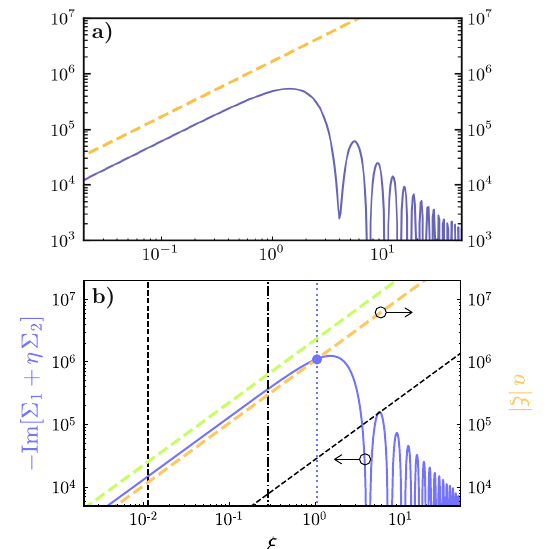
Figure 6. Steady-state solution for the mechanical displacement amplitude that ( a ) doesn’t reach a limit cycle, and ( b ) gets into a limit cycle. ( a ) The crossing of the left and right side of Equation (47) are reported as dashed–orange (for the first most coupled mode) and solid–blue curve, respectively. The oblique orange line represents the left term in Equation (47). The equation is not satisfied because the pump power is below the threshold for finding a root. ( b ) The intersection of left and right side of Equation (47) for the parameters of reference [23], are reported dashed–orange and solid–blue = 1.054, and an effective curves, respectively, determines the steady–state value of ξ st . We find ξ st 1 1 = 2 | A 1 | x zpf = 263.0 pm. The vertical dot-dashed black and dashed steady–state amplitude q st 1 lines represent the cavity response length λ 0 /2 F (cid:39) 43 pm, which corresponds to ξ cav (cid:39) 0.284, (cid:113) (cid:39) 3.365 pm, which corresponds to ξ (cid:39) 0.0112, k B T / m 1 ω 2 and the thermal displacement q th = th 1 respectively. The dashed light green line shows the left term in Equation (47) for the less coupled mechanical mode, for which, using the parameters of reference [23], the equation is not satisfied. The threshold power for the optical damping to exceed the intrinsic one, is ∼ 3 µW for the first oscillator, and 6.75 µW for the second. For a power larger than 6.75 µW both oscillators might reach a limit cycle [57]. The oblique black-dashed line shows the edge between the region with only one solution and the multistability region, which is possible only for a larger pump power ( P pump ∼ 667